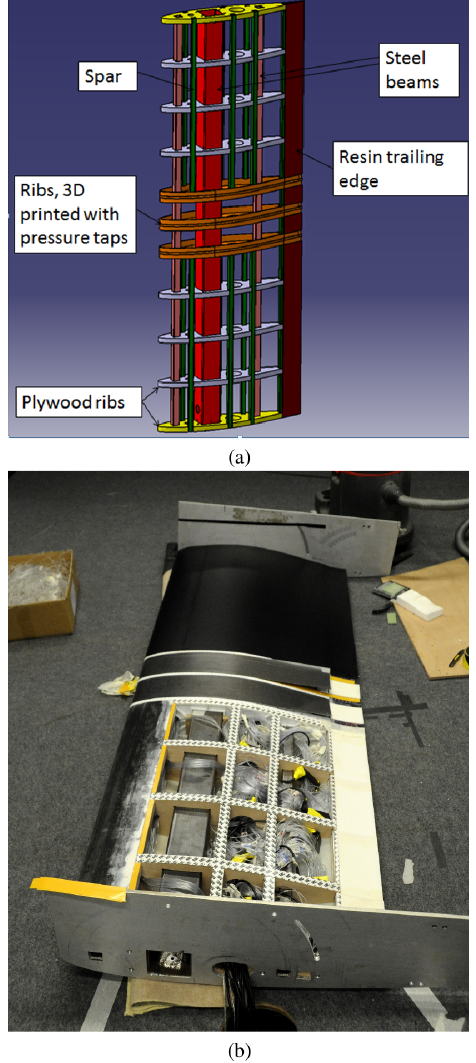
Figure 2. The blade manufacturing. (a) Elements of the skele- ton: two steel beams ensure the rigidity; plywood ribs ensure the blade aerodynamic shape; 3D-printed ribs are equipped with pres- sure taps; the trailing edge is made of resin. (b) Picture of the blade with one of the glass reinforced polymer skins removed.